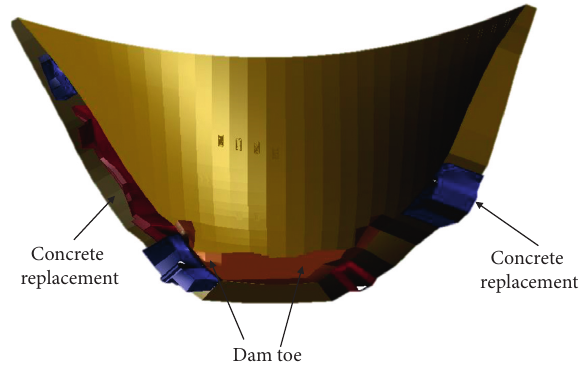
Figure 4: Relationship between foundation concrete replacement and dam toe (downstream).